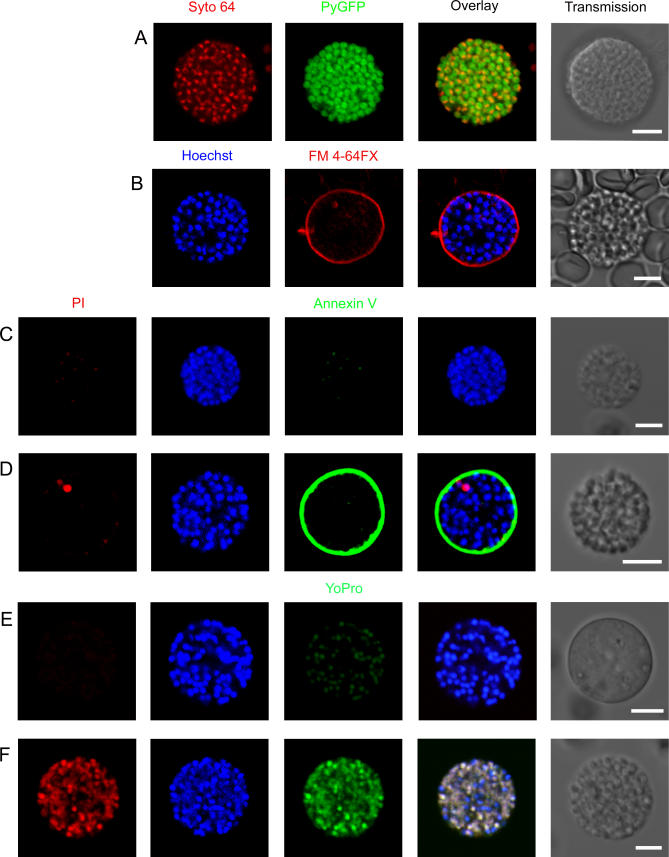
In Vitro Characterization of Hepatic Merosomes(A) Merozoite nuclei in a PyGFP merosome were visualized with the membrane-permeable DNA stain SYTO-64 (red). Differential interference contrast was used to capture the transmission image on the right of the panel.(B) The phospholipid marker FM 4–64FX was used to visualize the membrane surrounding the merosome (red). Merozoite nuclei were stained with Hoechst (blue).(C) Immediately after harvesting from the hepatic effluent, the majority of merosomes were negative for annexin V (green) and PI (red).(D) Prolonged in vitro cultivation led to PS exposure (green) in the outer leaflet of the merosomal membrane and to gradual incorporation of PI (red) into individual merozoite nuclei. Parasite nuclei were visualized with Hoechst (blue).(E and F) Freshly harvested merosomes excluded YO-PRO-1 (green), a DNA stain that selectively passes across apoptotic membranes, and the dead cell stain PI (red). In vitro incubation of the merosomes led to the simultaneous uptake of both nucleic acid stains suggesting that merozoite death occurred by necrosis rather than programmed cell death. Note that colocalization of YO-PRO-1, PI, and Hoechst causes nuclei to appear white. Bars = 5 μm.